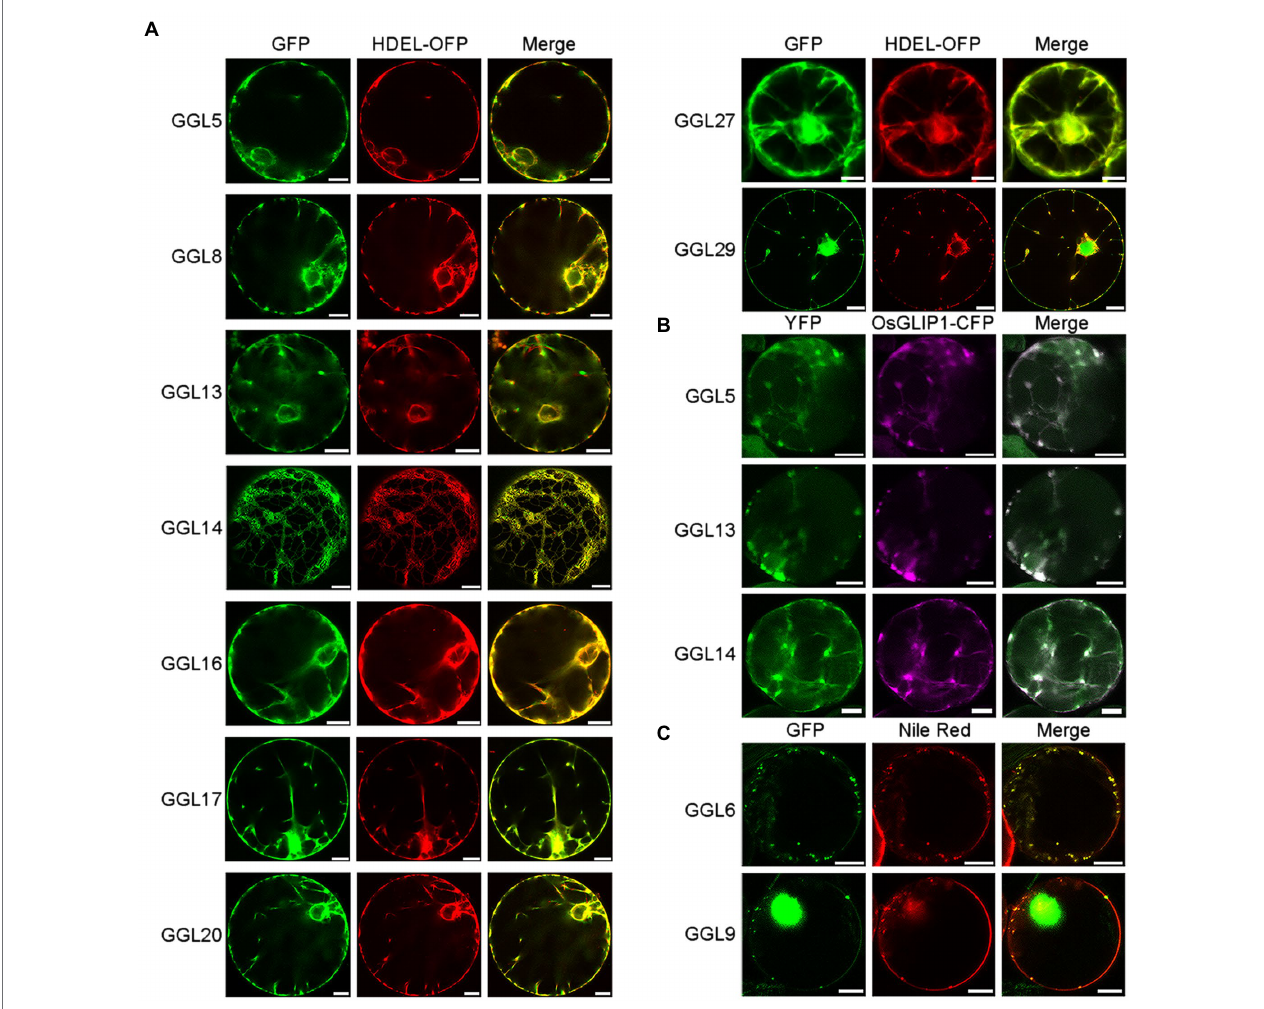
FIGURE 5 | Subcellular localization of GGLs in protoplasts of Nicotiana benthamiana leaves. Subcellular localization of C-terminal GFP or YFP fused GGL proteins in N. benthamiana protoplasts (A-C) . C-terminal GFP or YFP fused GGL proteins under the control of the CaMV 35S promoter were transiently expressed in N. benthamiana leaf epidermal cells. GFP or YFP signals in the isolated protoplasts were imaged by a confocal microscope. HDEL-OFP was coexpressed with GGLs to indicate endoplasmic reticulum localization (A) . Lipid droplet localization of GGLs was confirmed by co-localization with OsGLIP1-CFP (Gao et al., 2017) (B) or Nile Red staining (C) . Scale bar = 10 μ